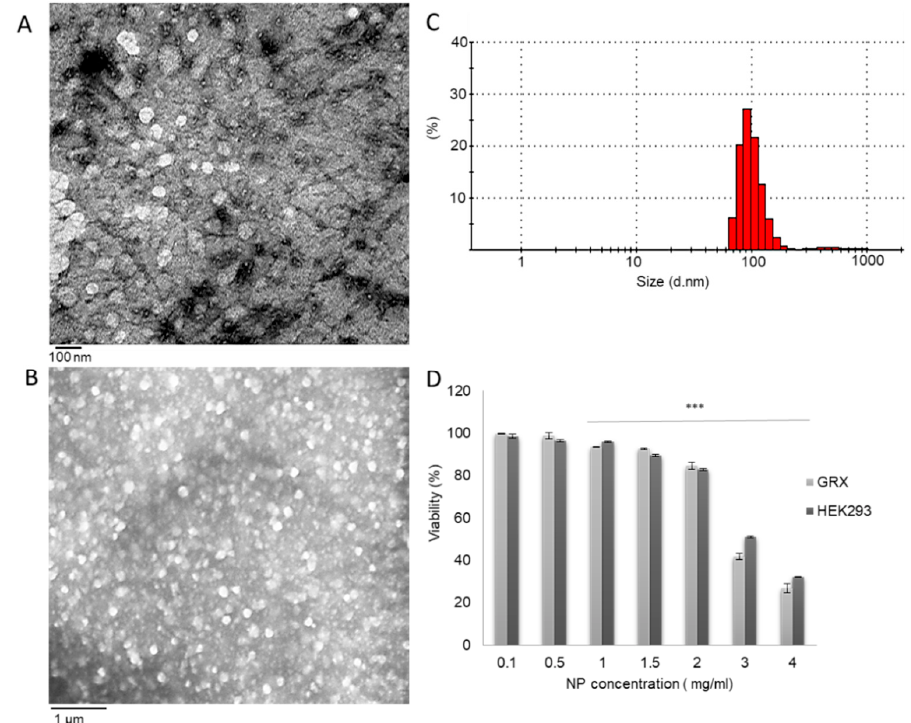
Figure 2. ( A ) Transmission electron microscopy and ( B ) scanning electron microscopy images obtained for chitosan nanoparticles ( C ) Hydrodynamic diameter distribution characterization by Dynamic Light Scattering. ( D ) The e ff ect of chitosan nanoparticles (CS-NPs) on GRX and HEK293 cell viability, as determined by the MTT assay. The results are presented as the mean ± SD viability relative to untreated cells (n = 4). Statistical analysis was performed by GraphPad InStat software using a one-way analysis of variance test (ANOVA), where (***) p < 0.001.